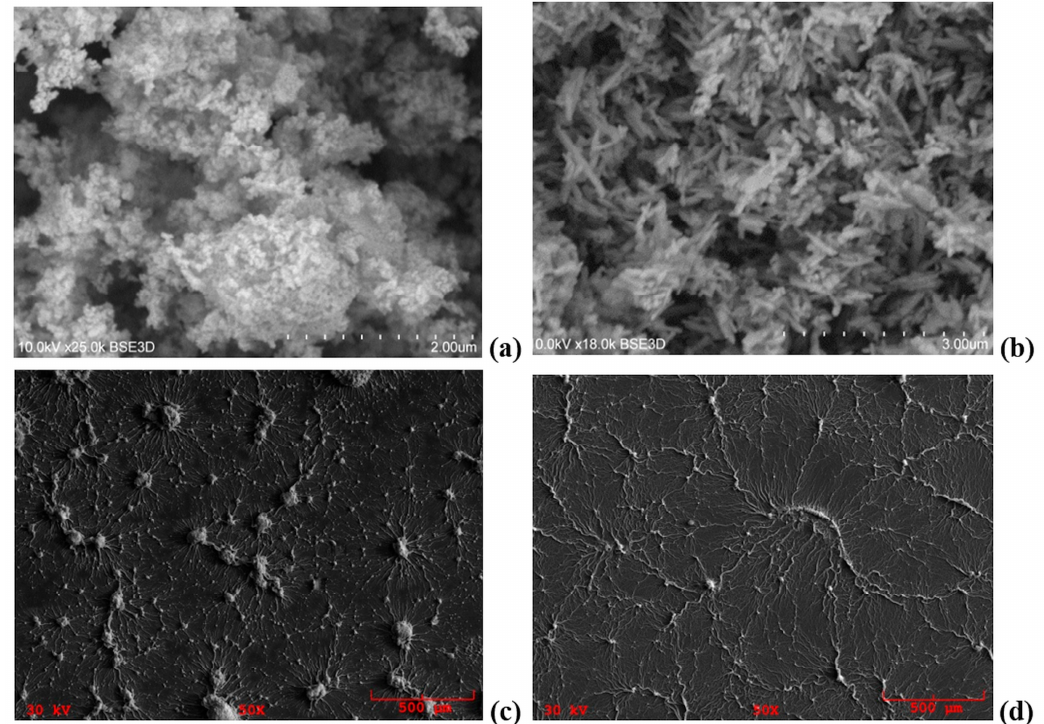
Figure 2. Morphology of Lu 2 O 3 :Eu ( a ) and Lu 2 O 3 :Tb ( b ) NPs as well as Lu 2 O 3 :Eu ( c ) and Lu 2 O 3 :Tb ( d ) films with thickness of about 300 nm.